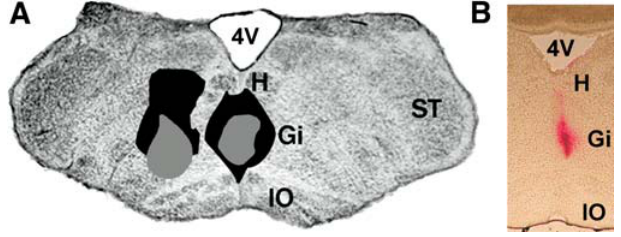
Figure 1. DiI Infusion Sites (A) Halos from 20 nl medial ( n = 5) and lateral ( n = 5) DiI infusions recreated from fluorescent photomicrographs on a coronal section of the medullary inhibitory area of a P8 rat. The largest (black) and smallest (gray) halos are shown. (B) Light photomicrograph of a representative DiI infusion site in the medial medulla. 4V, fourth ventricle; H, hypoglossal nucleus; Gi, nucleus gigantocellularis; IO, inferior olive; ST, spinal trigeminal nucleus DOI: 10.1371/journal.pbio.0030143.g001